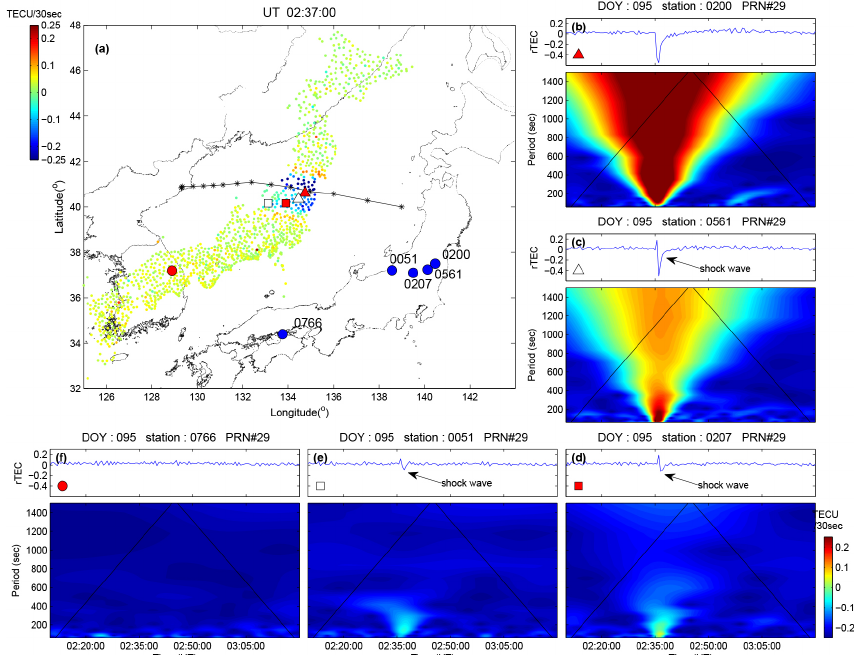
Figure 3. Two-dimensional rTEC maps derived from observations of GPS PRN#29 and wavelet spectrums of sub-ionospheric points (SIPs) located (b) in the middle of the TEC depletion region due to the chemical reaction of rocket exhaust (denoted by the closed red triangle); (c) at the edge of the shock wave and depletion region (denoted by the open triangle); (d) and (e) at the shock wave locations (denoted by the closed and open red rectangles); (f) far away from the rocket trajectory (denoted by the red closed circle) for the 2009 North Korean rocket. Closed blue circles indicate the five corresponding ground-based GPS receivers. Black lines indicate the cone-of-influence of wavelet analysis, which indicates the maximum period of useful information at that particular